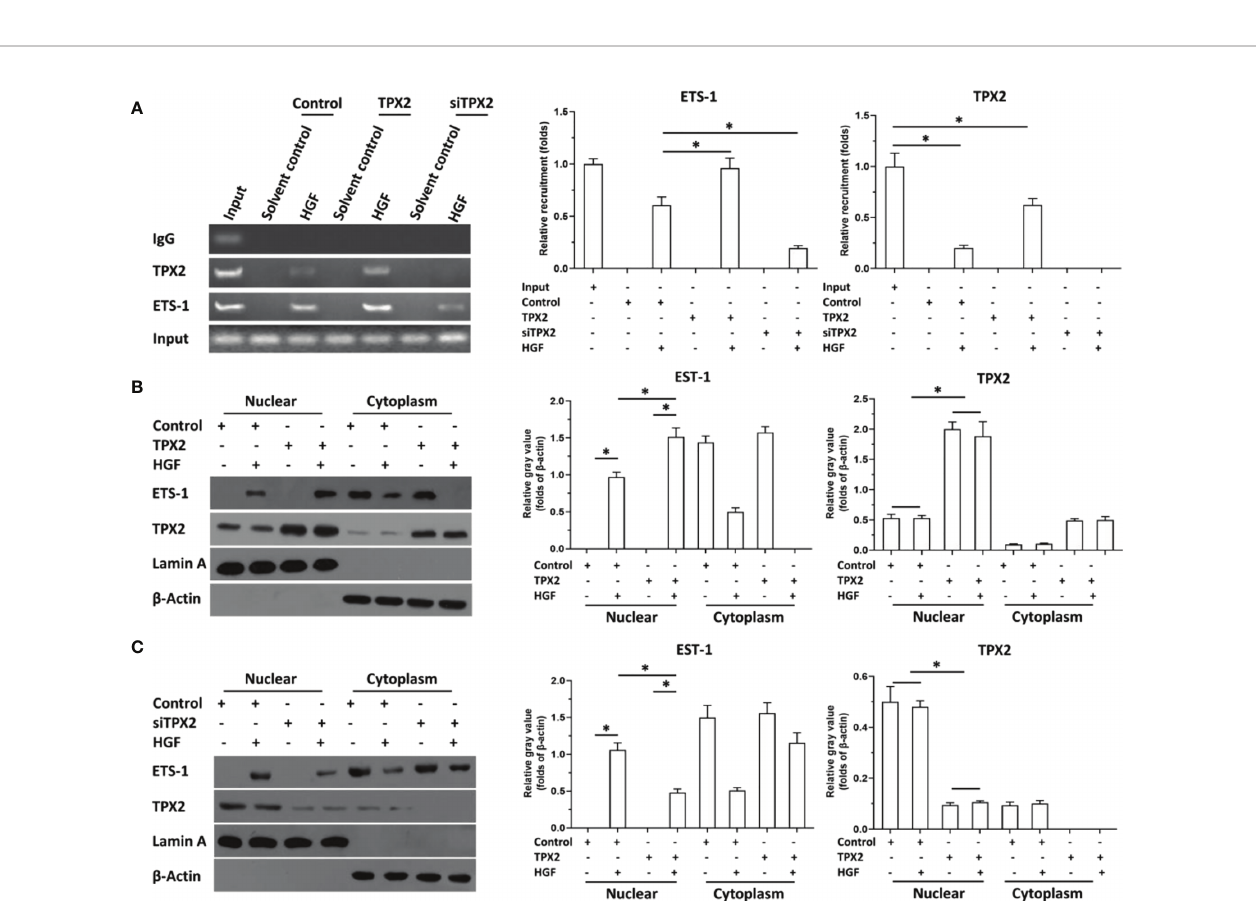
FIGURE 3 | TPX2 enhanced the recruitment of ETS-1 to mmp9 ’ s promoter or the accumulation of ETS-1 in PC-3 cells. The cells were treated with the solvent control or 10ng/ml concentration of HGF. PC-3 cells were transfected with the control, TPX2 or siTPX2. (A) cells were harvested for ChIP to examine the recruitment of ETS-1 to mmp9 ’ s promoter region. (B, C) cells were harvested for cellular sub-fraction to examine the accumulation of ETS-1 or TPX2 in the sub-fraction of PC-3 cells. The results were shown as images or the quantitative results were shown.